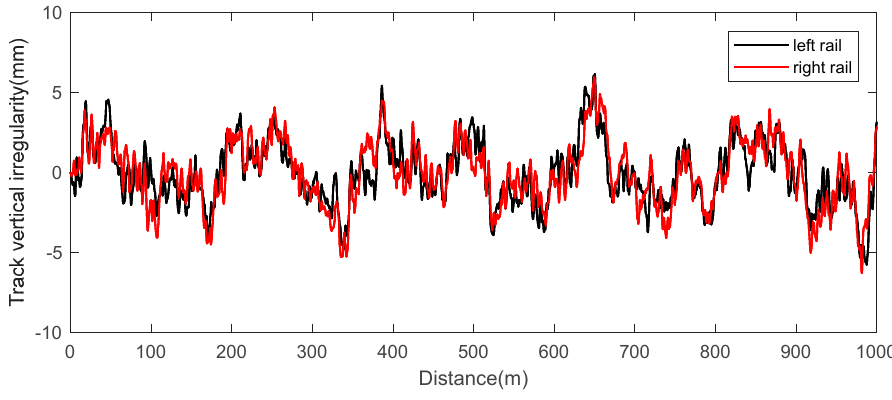
Figure 20. Track vertical irregularity.